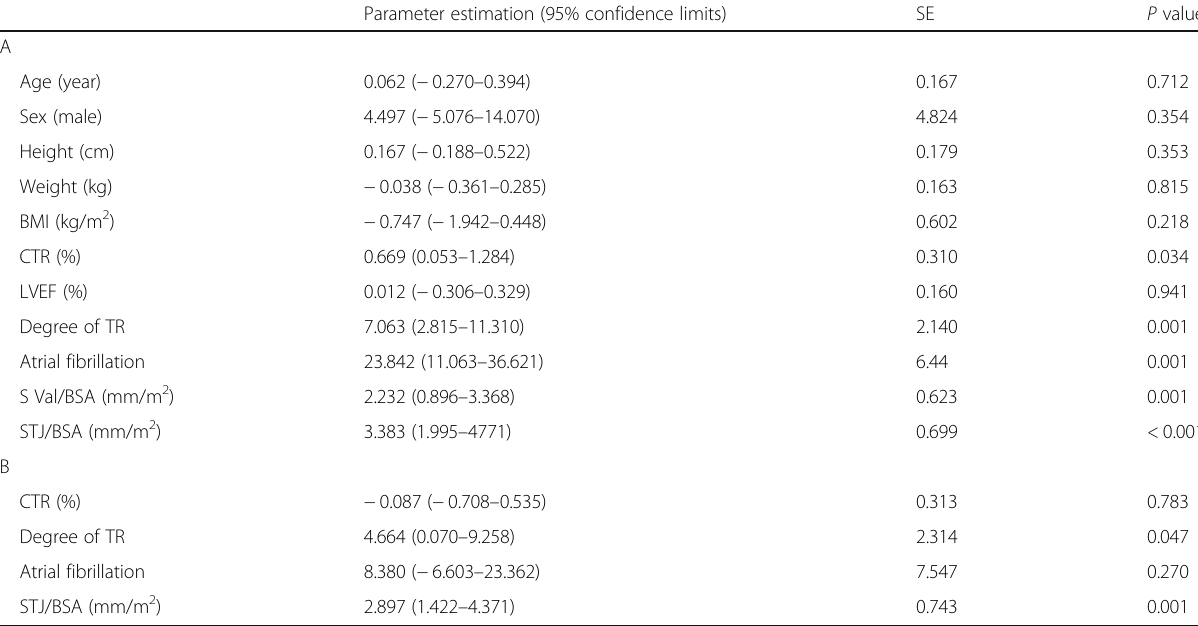
Table 4 Simple (A) and multiple (B) linear regression model of potential predictors of increased time duration to advance the catheter through the pulmonary valve Parameter estimation (95% confidence